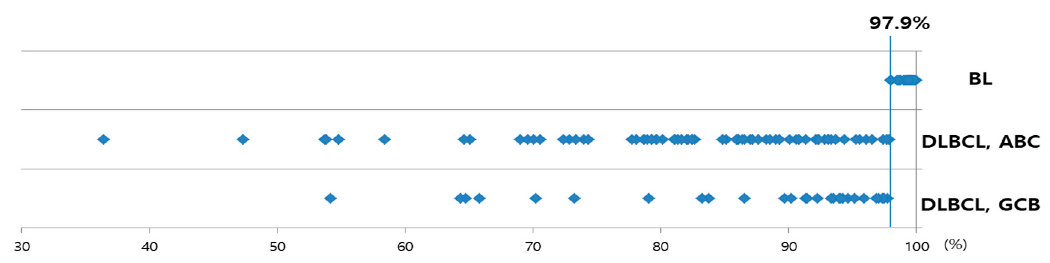
Figure 4. Dot plot of 2+/3+ cell proportions among positive cells of Burkitt lymphomas (BLs), diffuse large B-cell lymphomas (DLBCLs), and activated B-cell (ABC) and germinal center cell (GCB) subtypes .